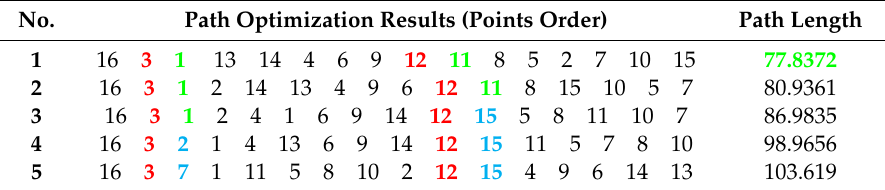
Figure 11. Data of flow and distance from point 3 to the remaining points. Table 3. Partial path optimization results under ulysses16